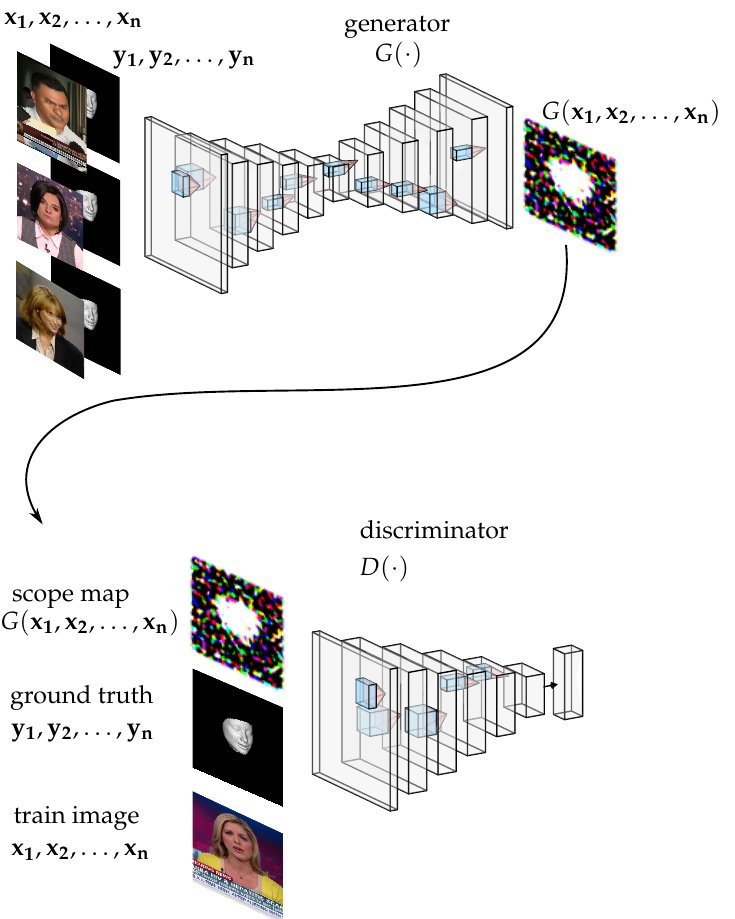
Figure 1. The architecture of the proposed method. The proposed method generates a score map using a generator network to predict fakeness probability for each pixel of the input image, and a discriminator network is used in the training stage to adjust the generator’s parameters to produce a realistic segmentation. The score map is used in the inference stage to determine manipulated pixels in the given